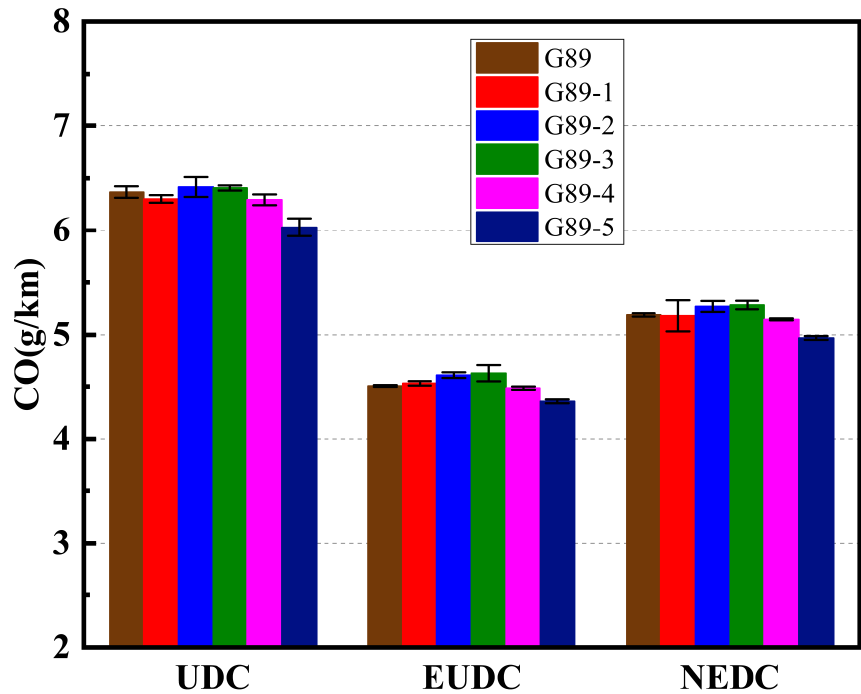
Figure 5. The CO emissions of the PFI vehicle when fueled with the different fuels. T50 plays a dominant role in CO emissions. The lower the value of T50, the better the volatility of the fuel, which helps to form a more uniform mixture, promote more complete combustion and reduce CO emissions [51]. As the T50 of G89-3 was significantly higher than the other fuels, more fuel-rich regions were likely to appear during the combustion process, so its CO emissions were the highest. Compared to G89, the T50 of G89-1 was significantly lower but its CO emissions showed an increasing trend. According to the literature [52], the optimal temperature range of T50 is about 95–100 ◦ C. When T50 is below 95 ◦ C, CO emissions will increase with the decrease in T50. Therefore, the CO emissions of G89-1 increased.